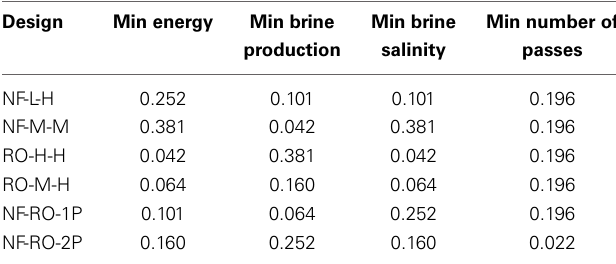
Table 6 | AHP pair-wise results of attribute weights.